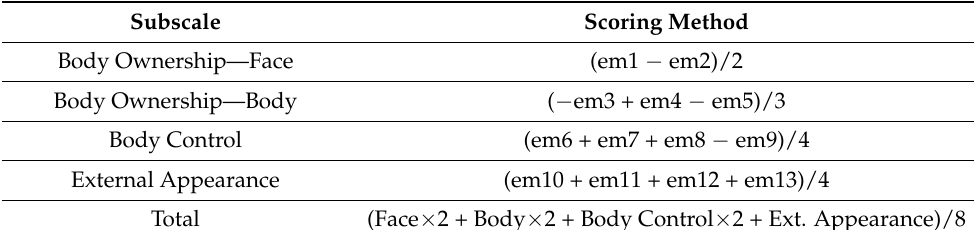
Table 2. Table 2. Embodiment scoring method (em: embodiment